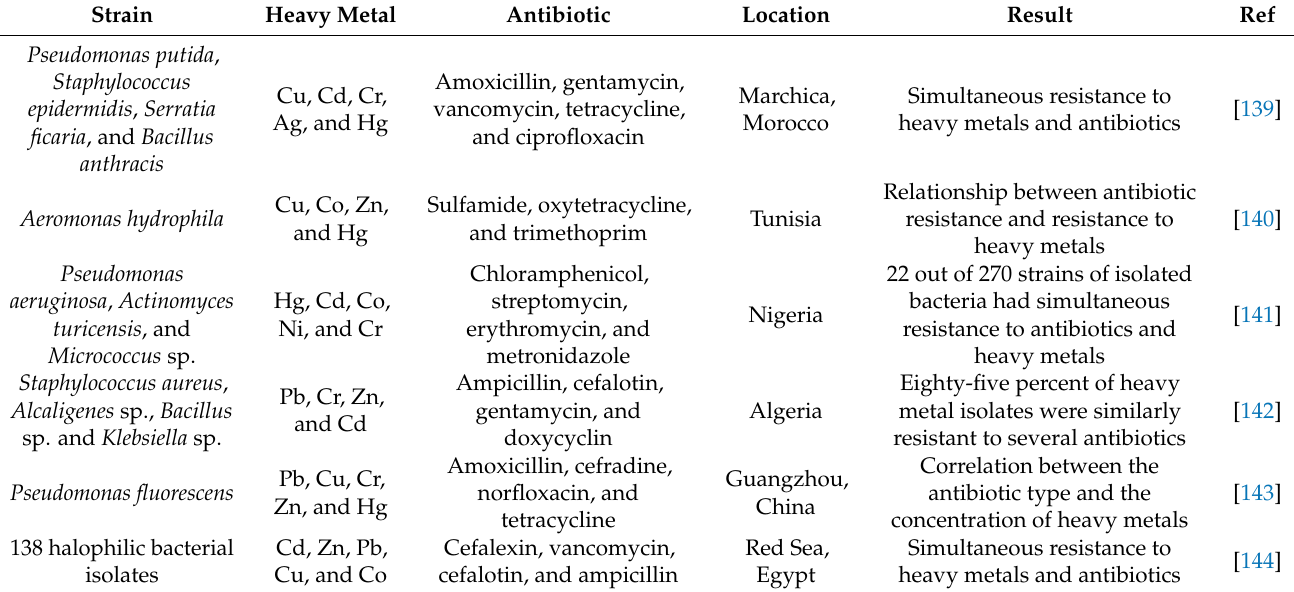
Table 2. Some studies regarding multiple resistances of bacterial strains to antibiotics and heavy